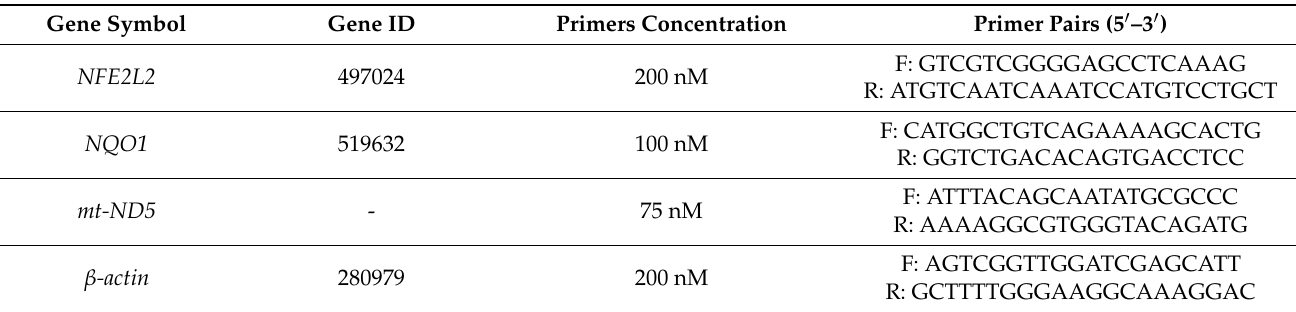
Table 1. Sequences of primer for quantitative reverse-transcription polymerase chain reaction (RT-qPCR), designed specifically for this